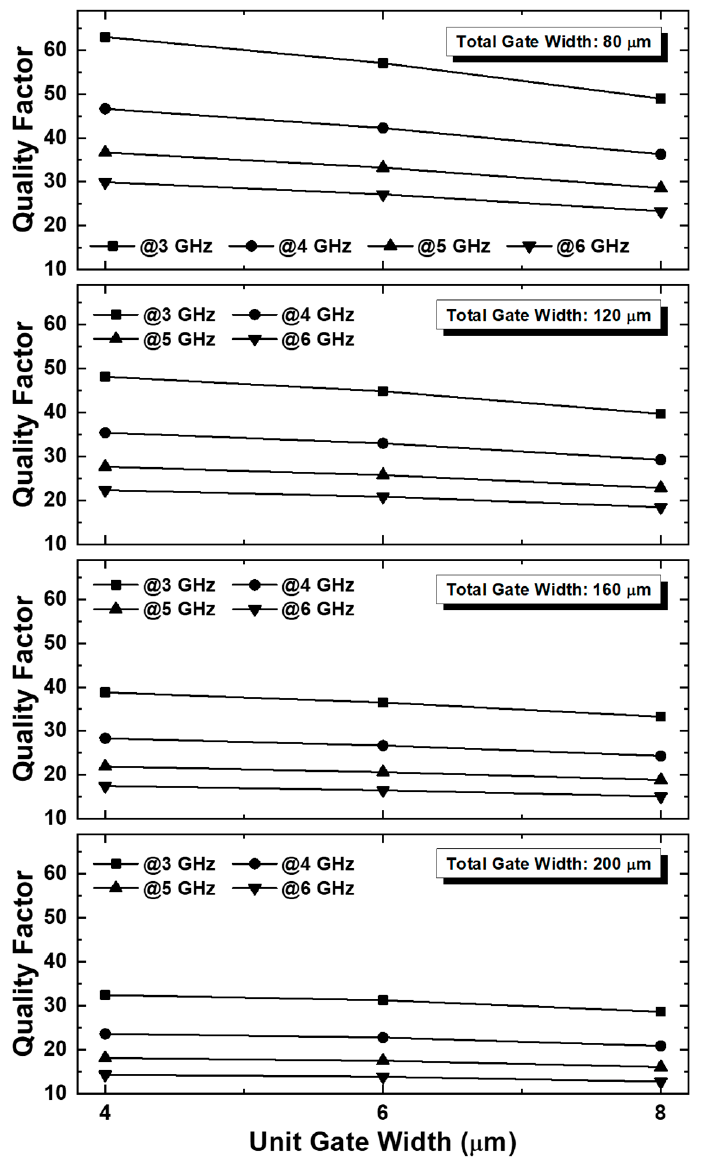
Figure 5. Simulation results of the quality factors of the MOS varactor according to the total gate width with V CTRL of 0.0 V.